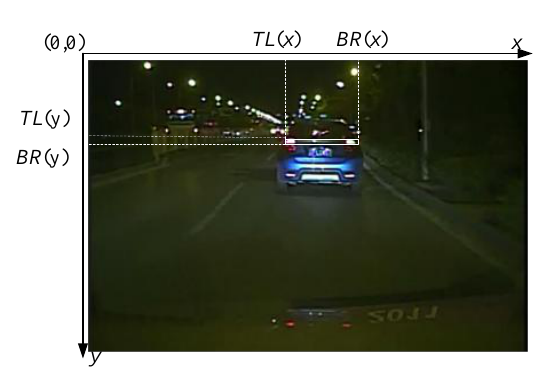
Figure 5. Vehicle position